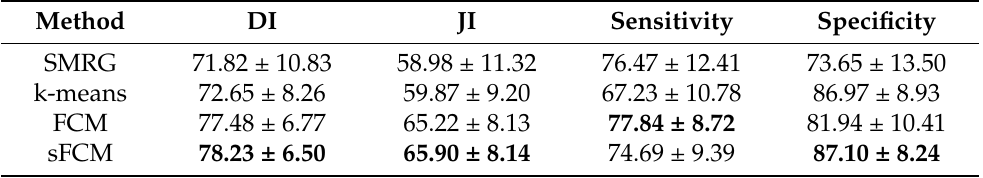
Figure 8. Boxplots of the area-based metrics achieved by the considered unsupervised segmentation approaches. From left to right: Dice Index, Jaccard Index, Sensitivity and Specificity. The lower and upper bounds of each box represent the first and the third quartiles of the metric distribution, respectively. The median is represented by a red line, while outliers are displayed as red crosses. Table 3. Area-based metrics achieved by the considered unsupervised segmentation approaches: the results are expressed as average value ± standard